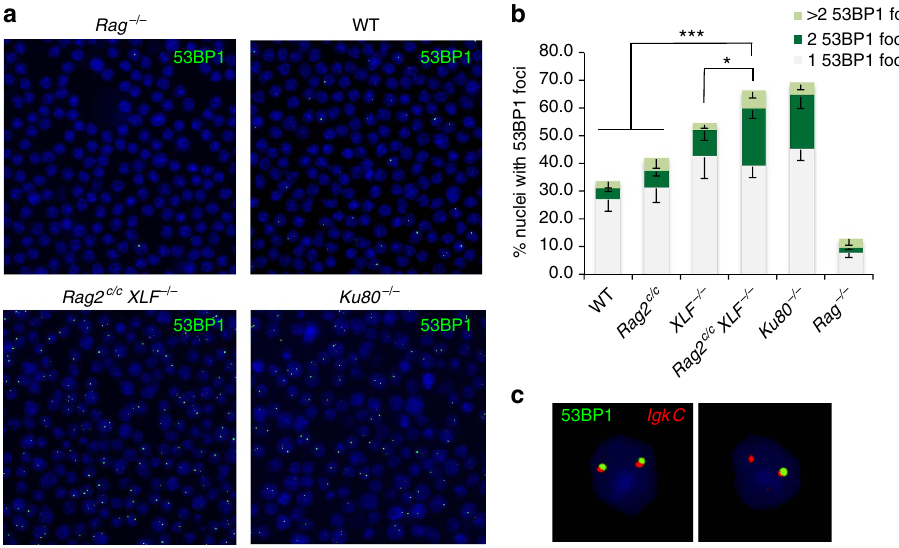
Figure 3 | Accumulation of RAG-induced 53BP1 foci in Rag2 c/c XLF (cid:2) / (cid:2) B cells. ( a ) Representative 3D projections of 53BP1 immuno-staining conducted on ABLki-treated v-abl pro-B cells. ( b ) Percentage of v-abl pro-B cells harbouring 1, 2 or 4 2 53BP1 foci 65h post-ABLki treatment. Histograms represent means ± s.d. from four independent experiments with two independent cell lines for each genotype (see Supplementary Table 1 for details). *0.01 r P o 0.05, *** P o 0.001. ( c ) Fluorescent light microscopy images of immuno-3D FISH analysis conducted on ABLki-treated Rag2 c/c XLF (cid:2) / (cid:2) v-abl pro-B cells. Nuclei were stained with anti-53BP1 antibody (green) and subsequently hybridized with the centromeric Igk BAC probe ( Igk C , red). Images show 2 nuclei with coincident 53BP1/ Igk signals (see Supplementary Fig. 4 for